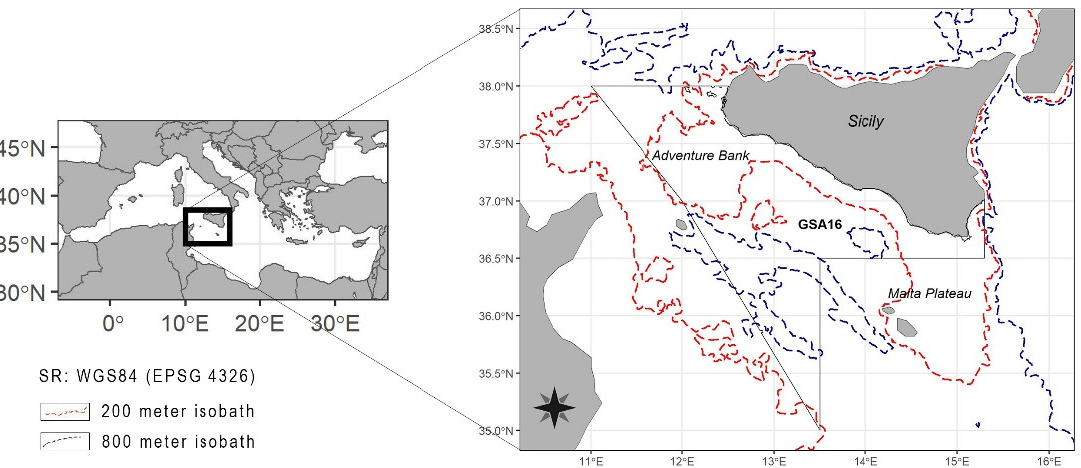
Figure 1 . Investigated area, highlighted in the black square. Figure 1. Investigated area, highlighted in the black This area represents one of the most important fishing grounds for demersal species, exploited mainly by trawl fisheries [55]. In particular, the trawling fleet exploits the deeper fishing ground, targeting deep-water crustaceans such as Aristaeomorpha foliacea , Aristaeus antennatus , and Nephrops norvegicus [59,60], as well as the shallow fishing ground, targeting mainly M. barbatus , M. surmuletus , sparids and cephalopods [43,61]. Among these fishing typologies, an important component of commercial and discarded bycatch comprises cartilaginous fishes [62].